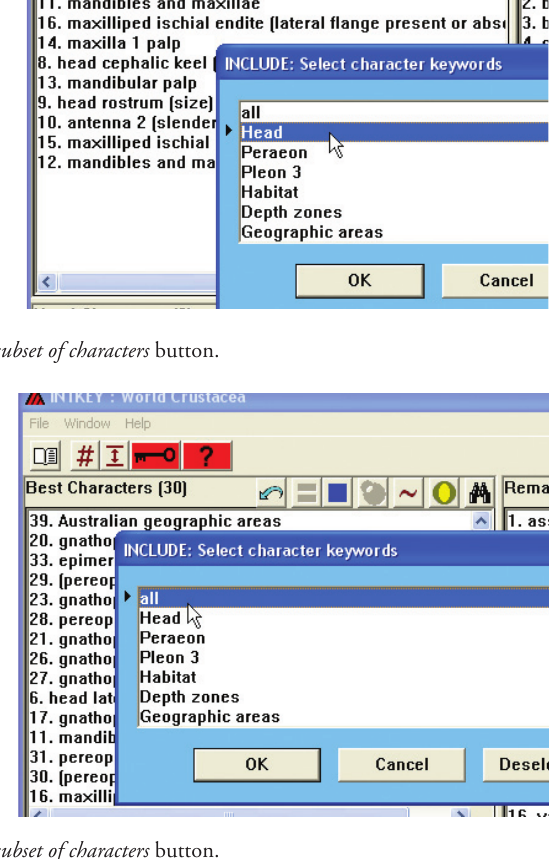
Figure 51. Use a subset of characters button.